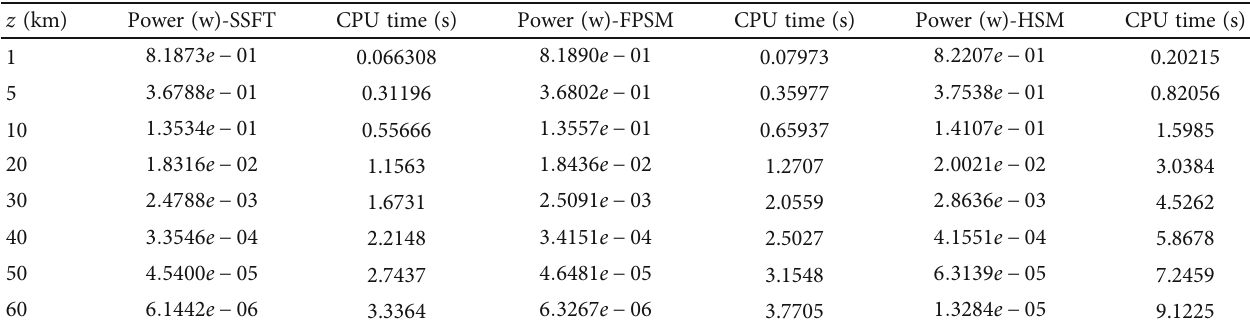
Table 5: A comparison of the pulse powers using the split-step Fourier transform (SSFT), the Fourier pseudospectral method (FPSM), and the Hopscotch method (HSM), at an attenuation constant α = 0 : 2 dB/km, computed at di ff erent distances z from 1 to 60km. z (km)